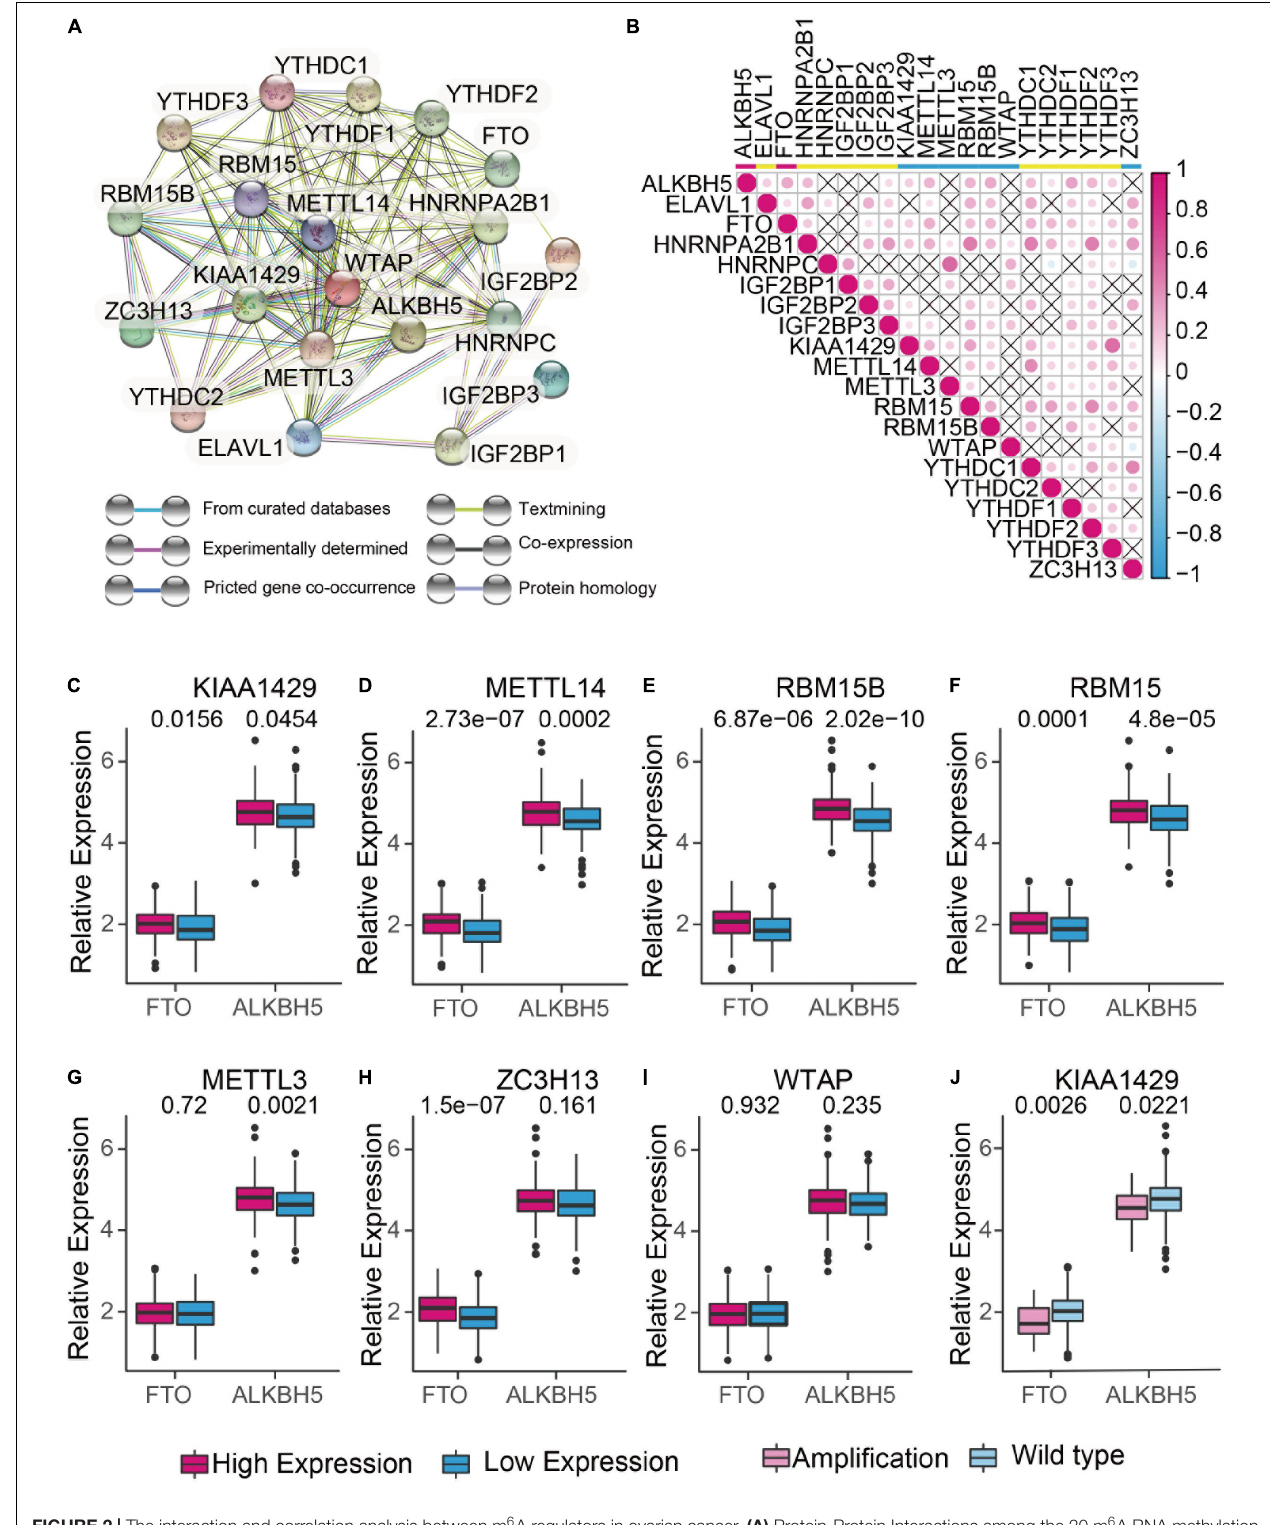
FIGURE 2 | The interaction and correlation analysis between m 6 A regulators in ovarian cancer. (A) Protein-Protein Interactions among the 20 m 6 A RNA methylation regulators using STRING 11.b. (B) Spearman correlation analysis of 20 m 6 A RNA methylation regulators in TCGA cohorts using R. (C-I) Correlation analysis between the expression of “erasers” (FTO and ALKBH5) and “writers” (KIAA1429, METTL14, RBM15, RBM15B, METTL3, ZC3H13, and WTAP). Median expression value was used to divide the patients into high and low expression groups. (J) Difference in the gene expression of “erasers” between KIAA1420-amplified and wild types.